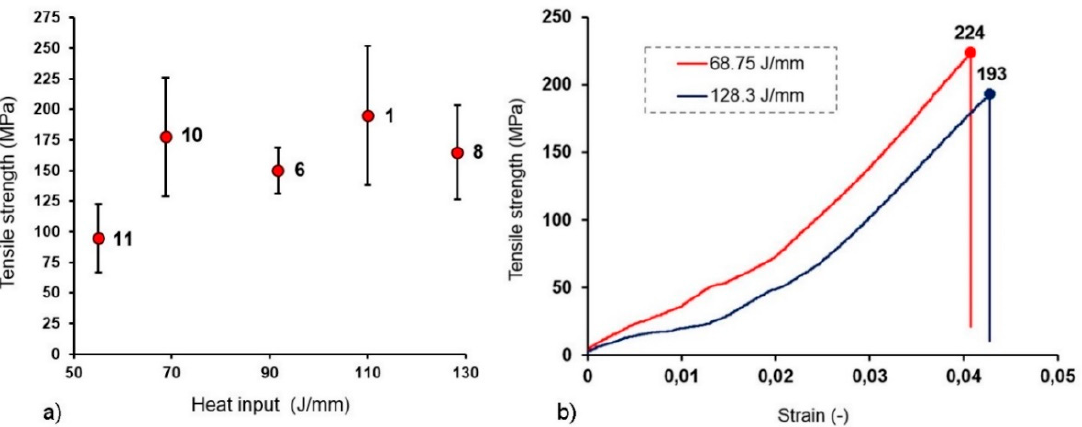
Figure 14. Heat input influences the weld strength ( a ). Stress–strain curves of electron beam welded joints 8 (128.3 J/mm) and 10 (68.8 J/mm) ( b ).